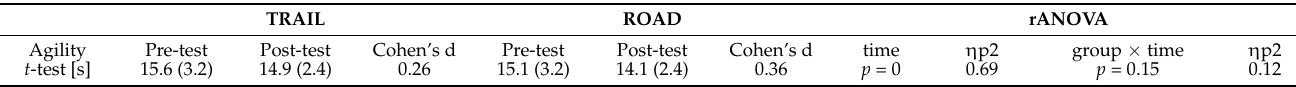
Table 5. Effect on